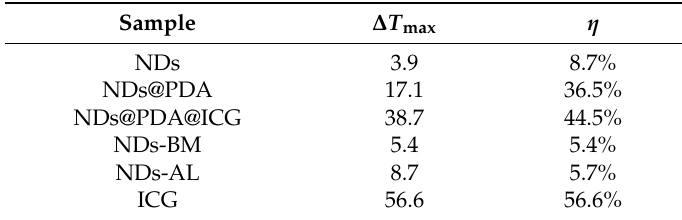
Table 2. Comparison of photothermal conversion efficiency ( η ) of different NDs-based nanoparticles.